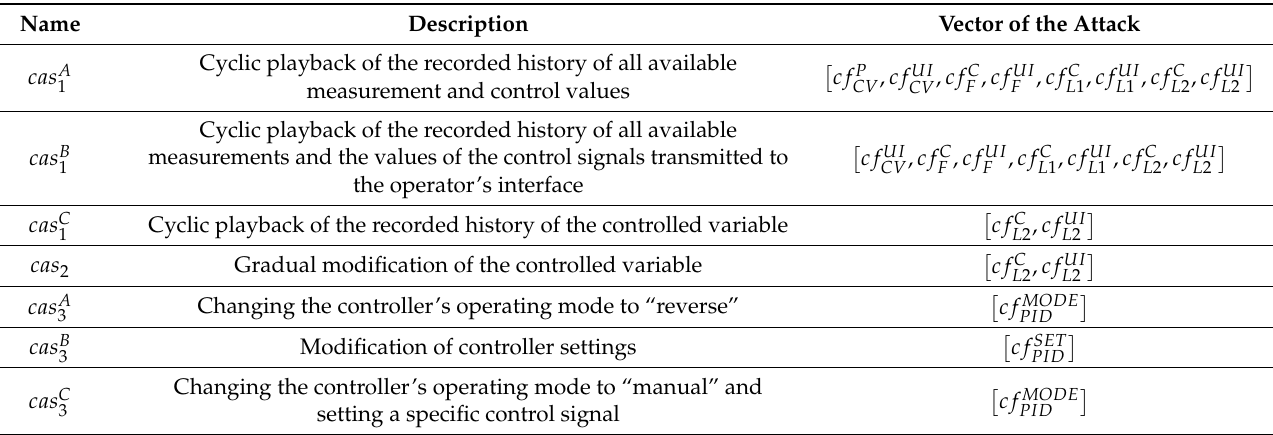
Table 4. The set of considered cyber-attack scenarios.